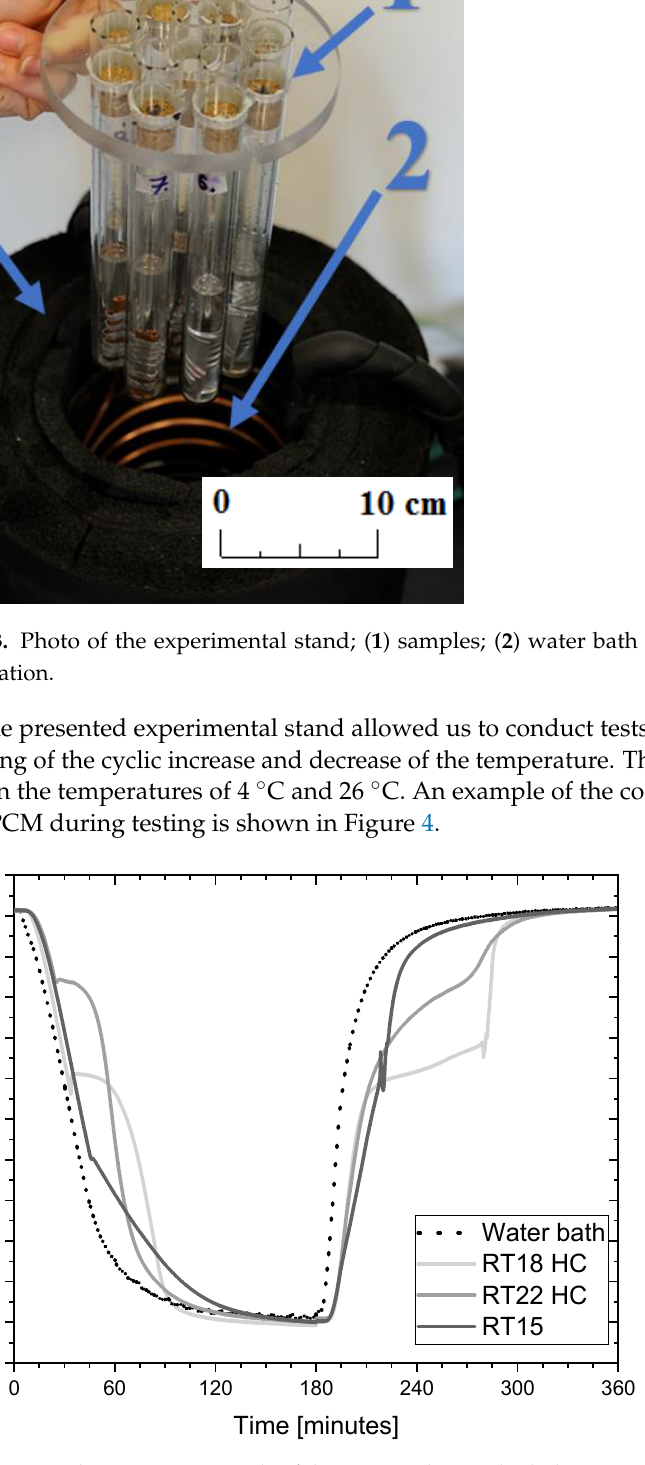
Figure 4. Typical temperature trends of the PCM and water bath during a typical cooling and heating cycle in testing of these materials.